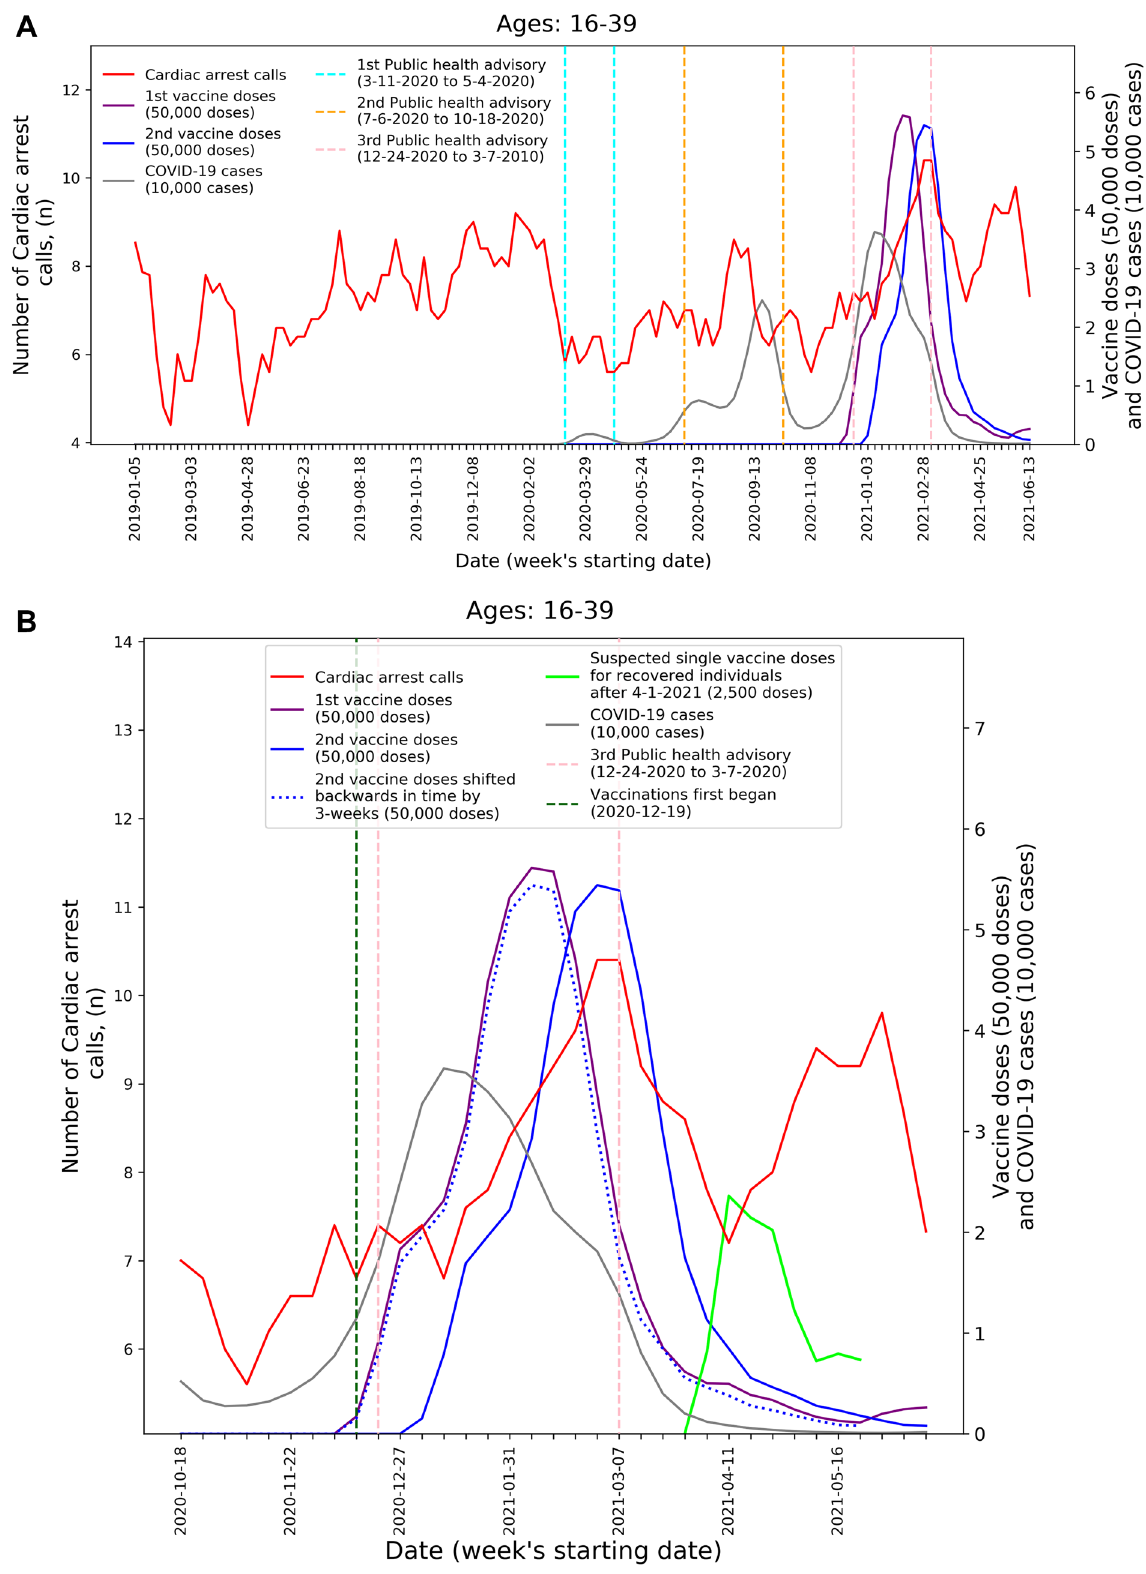
Figure 1. Weekly counts of cardiac arrest calls (five-week centered moving-average), COVID-19 cases (three- week centered moving-average), and vaccination doses (three-week centered moving-average) for those between 16 and 39 during: A) the study period (January 1st, 2019, to June 20th, 2021) and B) the third COVID-19 wave and vaccination distribution period (October 18th, 2020, to June 20th, 2021). COVID‑19 Coronavirus disease